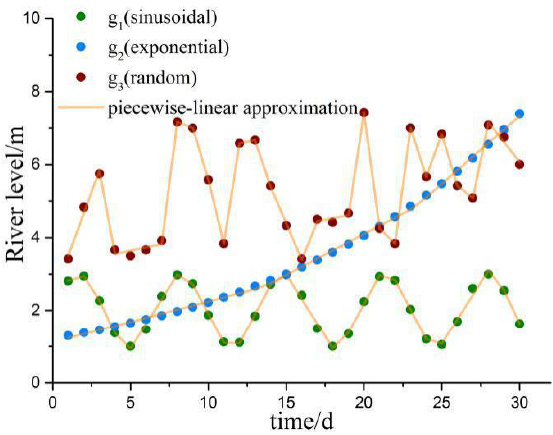
Figure 2. River level variations for sinusoidal ( g 1 ), exponential ( g 2 ), and random ( g 3 ) characteristics with piecewise-linear approximation.